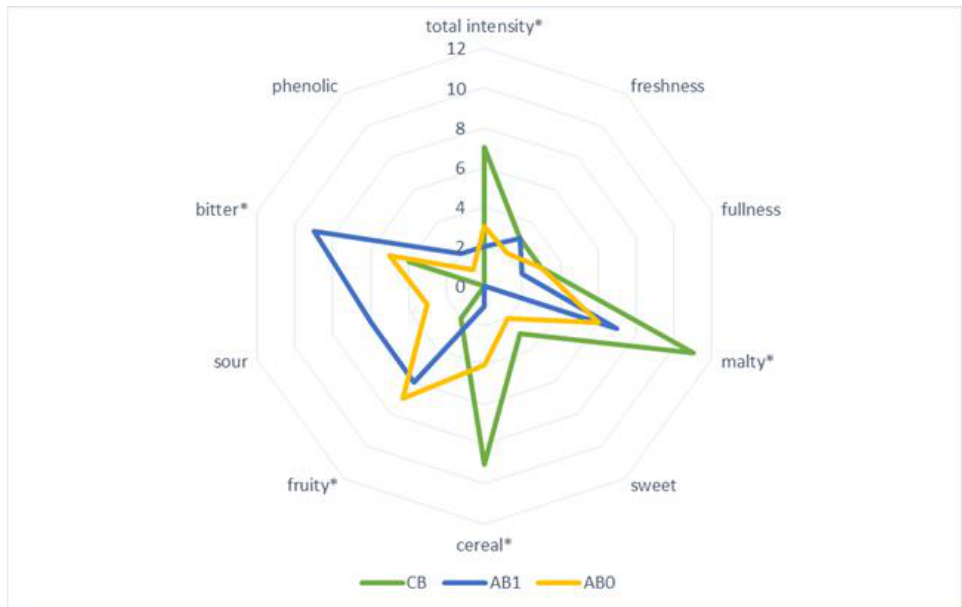
Figure 6. Sensory profile of barley beers —control (CB) and sample with addition of ‘Amela’ cultivar fruit untreated (AB1) and treated with ozone (AB0); * marks the attributes which were statistically different at p ≤ 0.05.